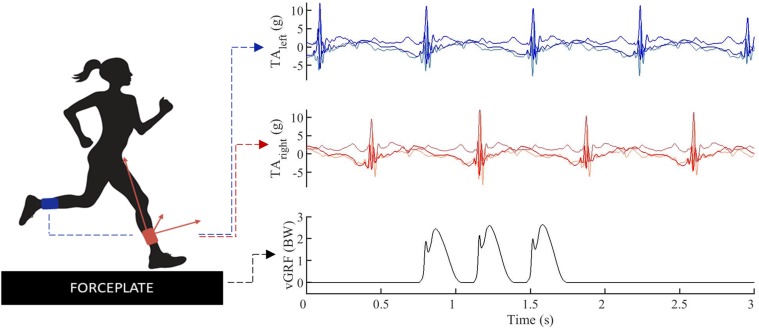
Data example, tri-axial.1pc accelerations (TA) were simultaneously captured for the left (blue) and right (red) lower leg, vertical ground reaction forces (vGRF) were synchronized in time (black).